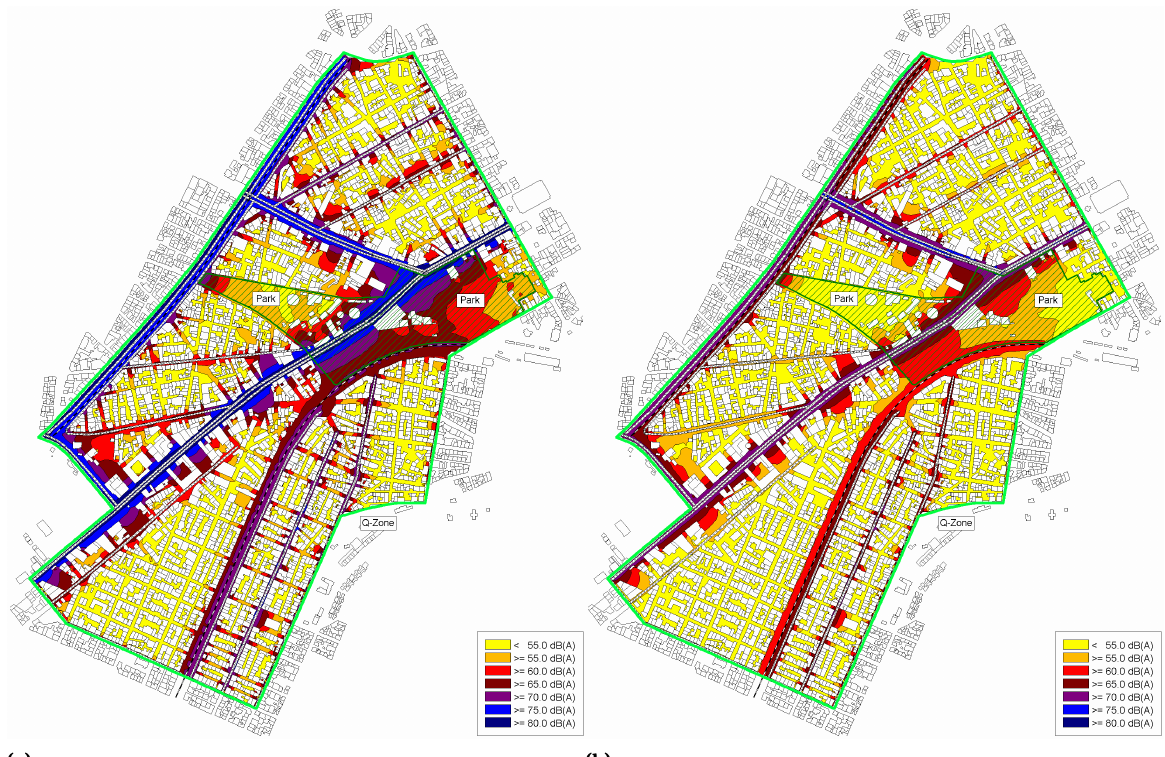
Figure 2: Noise map (L de & L night ) of the Athens Q-Zone: Base case scenario S01. left and right section, which are specified